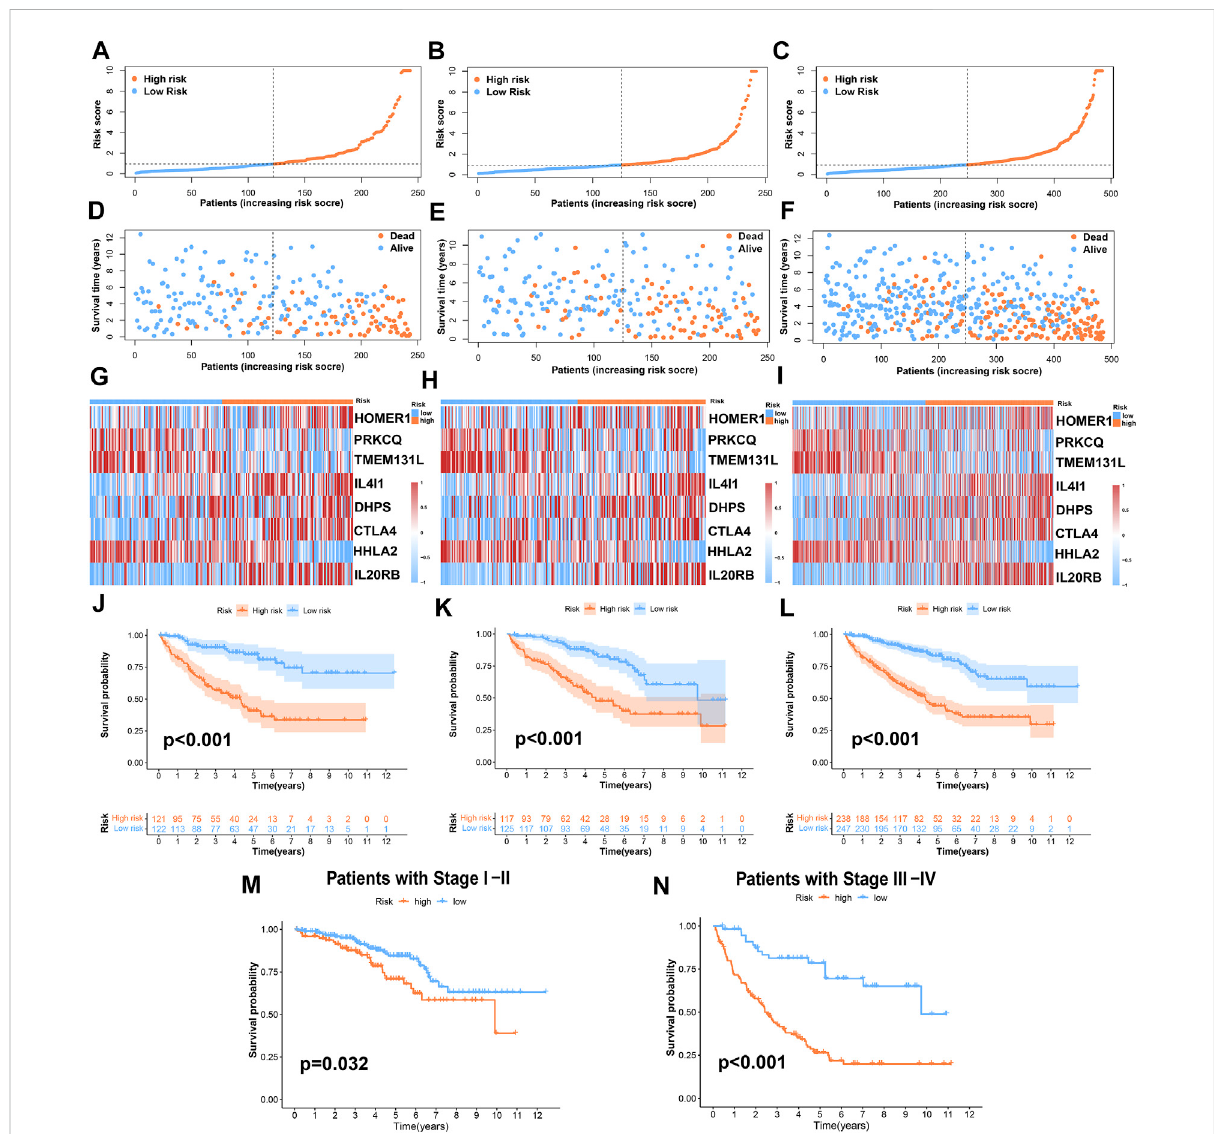
FIGURE 4 Prognosis value of the risk-strati fi ed model in the train, test, and entire sets. (A – C) The risk-strati fi ed model was based on 8 TRGs of the train, test, and entire sets, respectively; (D – F) the exhibition of survival time and survival status between low- and high-risk groups in the train, test, and entire sets, respectively; (G – I) the heatmap of 8 TRGs in the train, test, and entire sets, respectively; (J – L) Kaplan – Meier survival curves of OS of patients between low- and high-risk groups in the train, test, and entire sets, respectively. (M,N) Kaplan – Meier survival curves of OS of patients between low- and high-risk groups strati fi ed by tumor